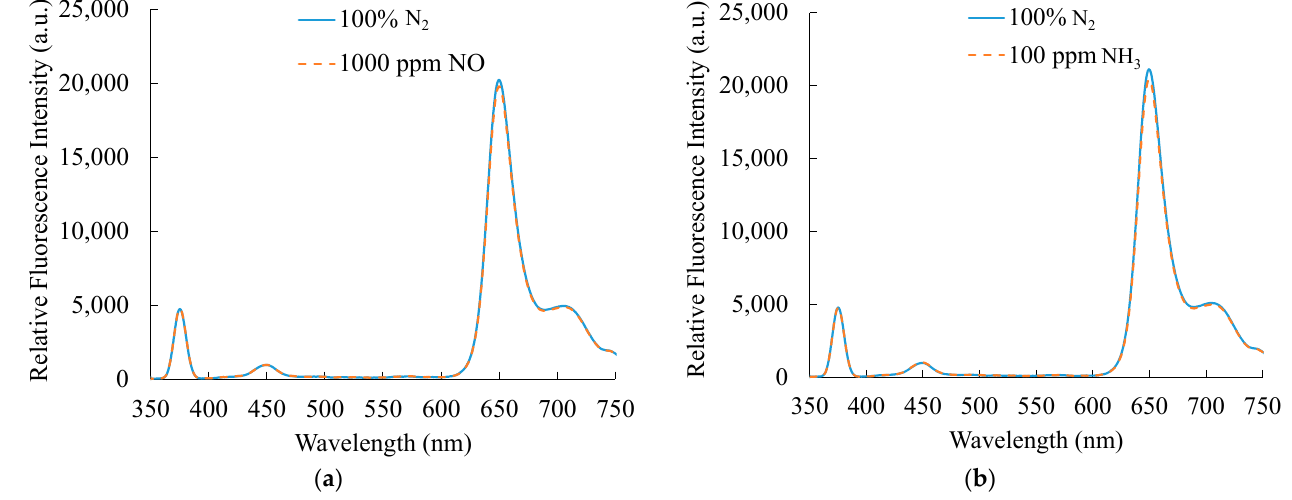
Figure 8. Responses of the optical dual sensor towards (a) NO and (b) NH 3 .